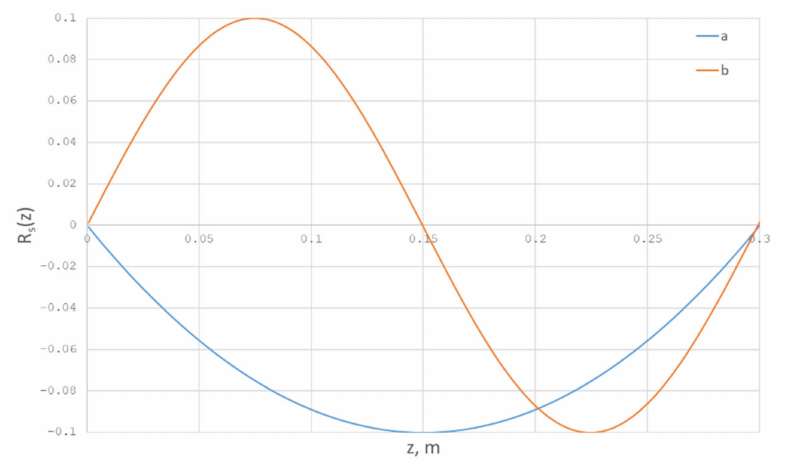
Figure 22. Radius drawing deviation (as a fraction of the stationary solution).